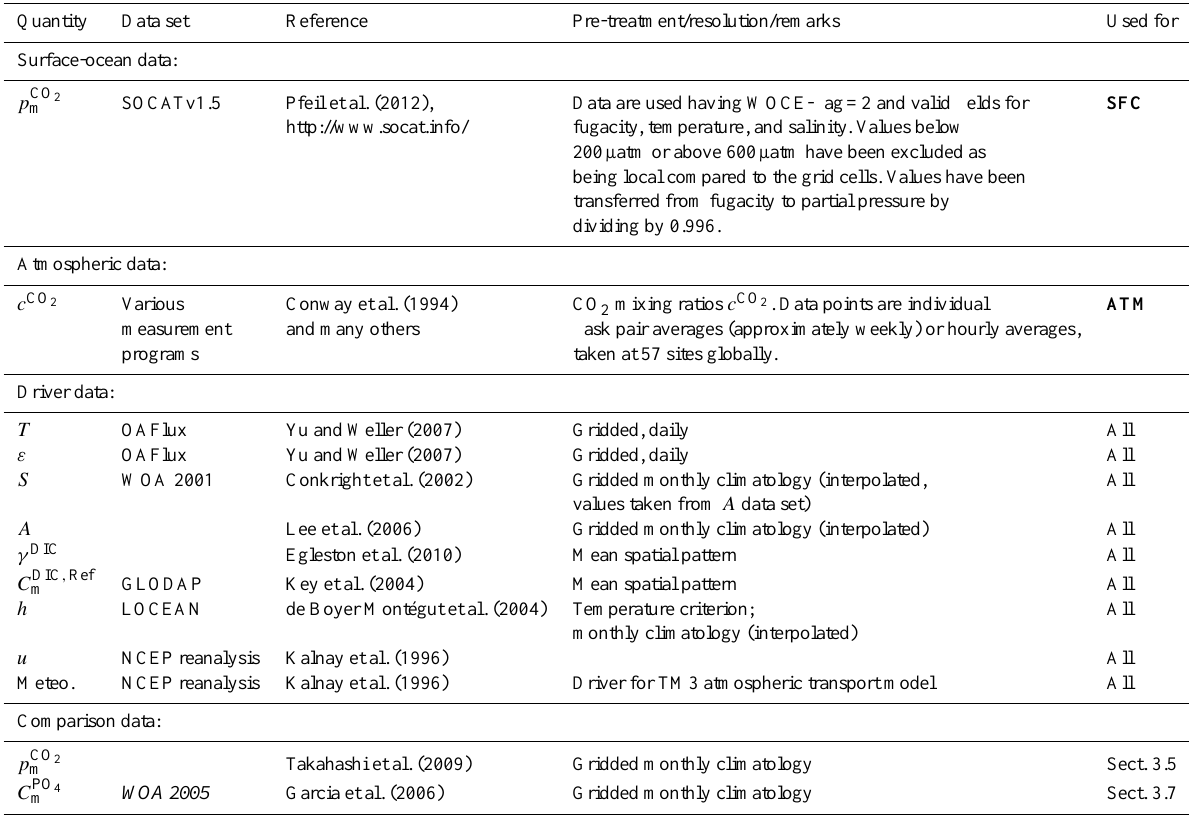
Table 1. Data sets used as constraints or as driver data in the process parameterizations (Sect. A1). Quantity Data set Reference Pre-treatment/resolution/remarks Used